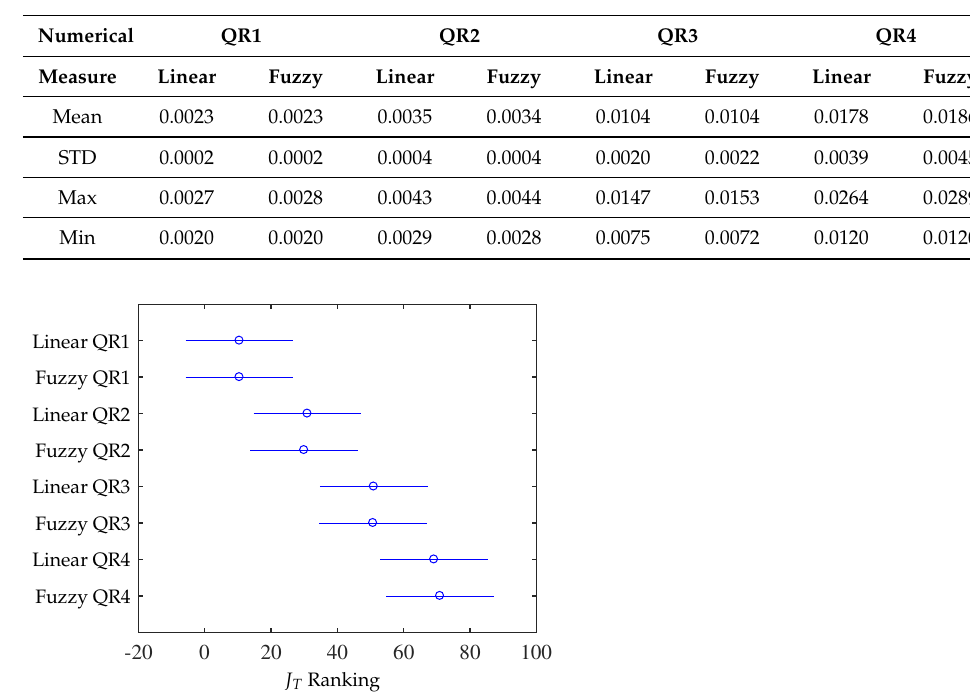
Table 7. Numerical measures of J T for 10 simulations considering disturbance rejection.